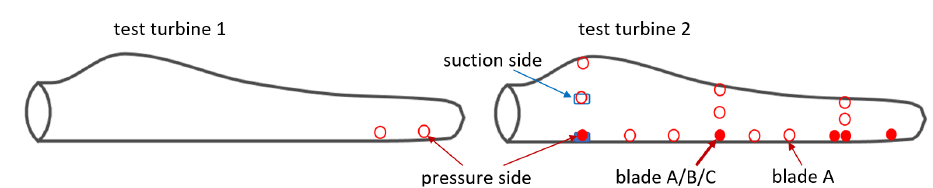
Figure 3. ( Left ) Sensor positions of Sensors S 1 and S 2 on Test Turbine 1. ( Right ) Sensor positions of Sensors S 3– S 32 on Test Turbine 2. Positions are marked with red circles and blue rectangles for positions on pressure side and suction side, respectively. Marker faces are solid for sensors deployed on all three blades and blank for sensors only deployed on the first blade (Blade A ). Allocation of sensor numbers and positions displayed with results in the remainder of this